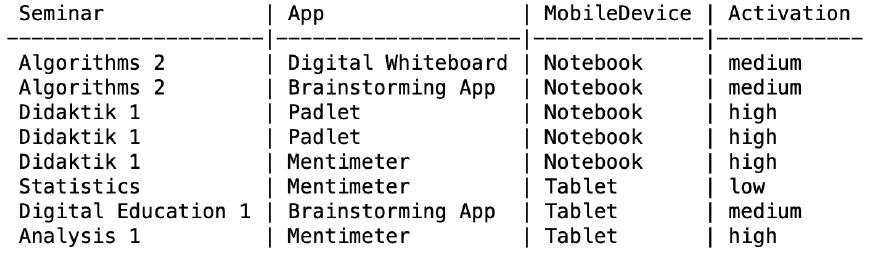
Figure 6. Table output of Cypher query.